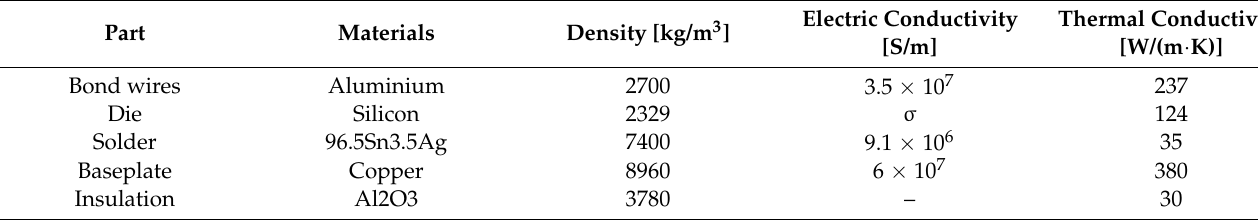
Table 1. Material Properties of FEM Model.